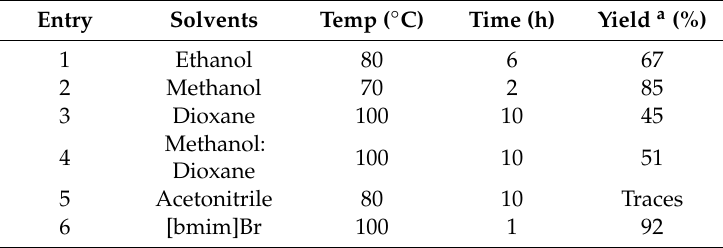
Table 1. Solvent optimization for the synthesis of spirooxindole–pyrrolidine heterocyclic hybrid 8e . Entry